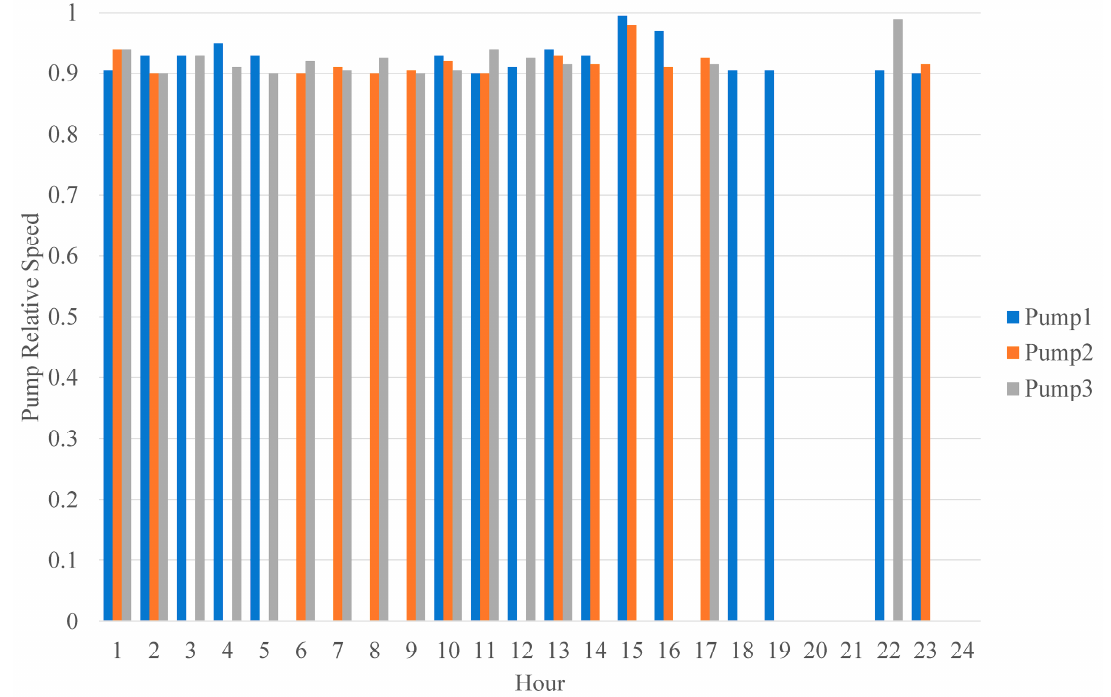
Figure 8. Optimal sequence of relative pump speeds for Case 2.